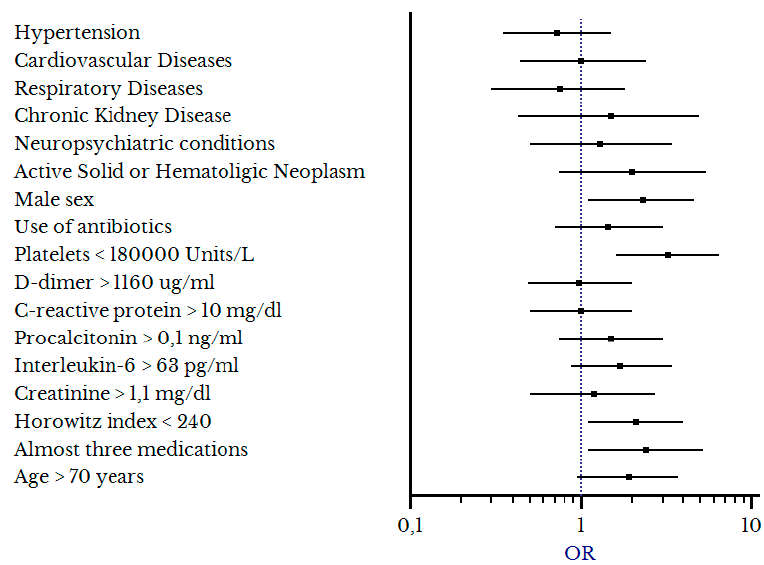
Figure 4. Forest plot rendering factors associated with hCPAP failure.